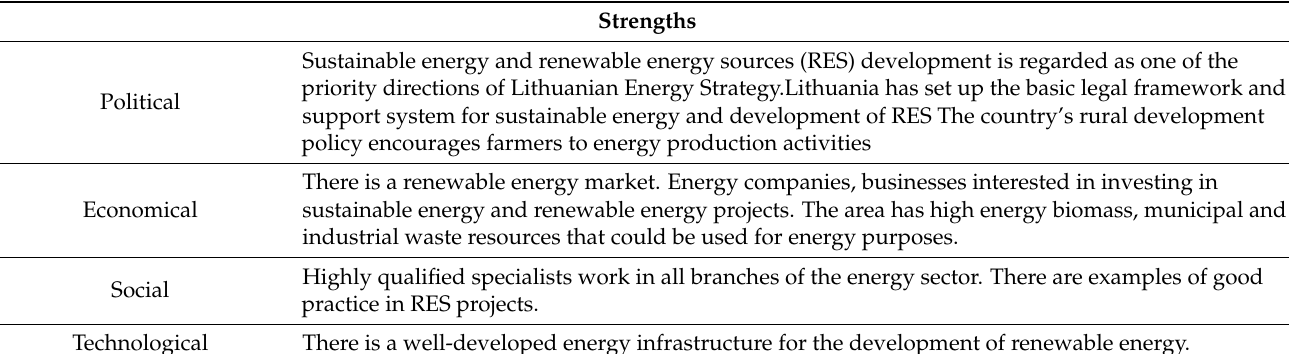
Table 3. SWOT analysis of RES development in